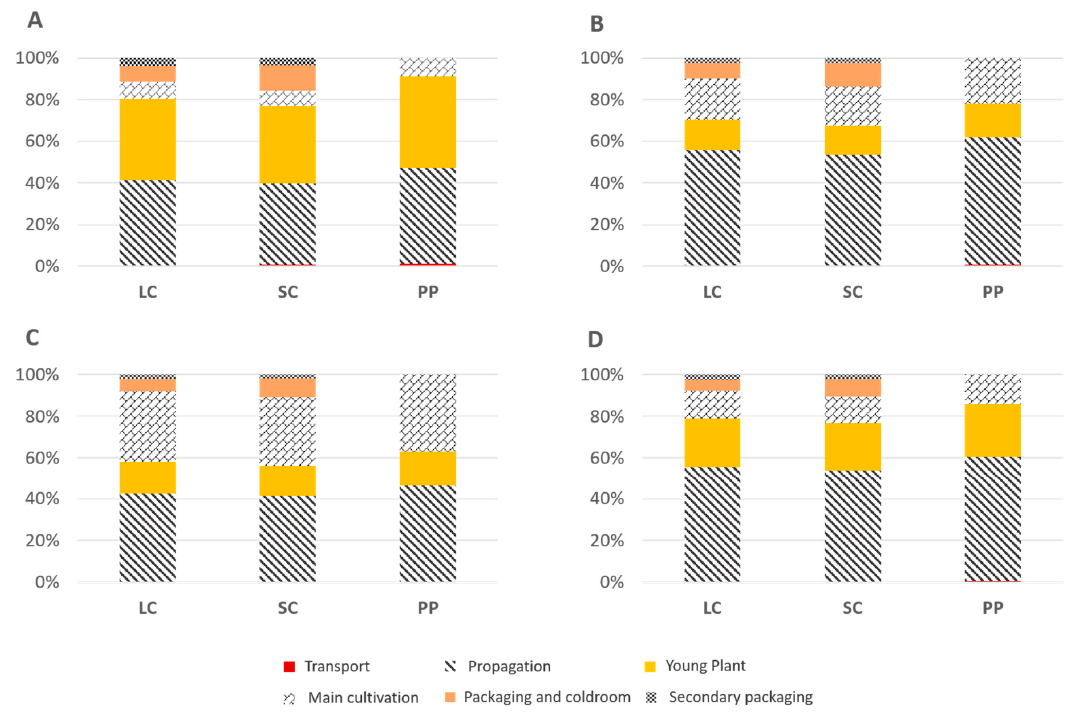
Figure 3. Begonia semperflorens relative contribution (%) to the impact categories of each life cycle stage. Transportation stage is scarcely visible at this scale since it accounts for a small part of the total contribution. Each column shows the production burdens related to a specific type of final product: LC = Large Container. SC = Small Container. PP = Potted Plant. A : Global Warming Potential (GWP). B : Acidification Potential (AP). C : Eutrophication Potential (EP). D : Photochemical Ozone Creation